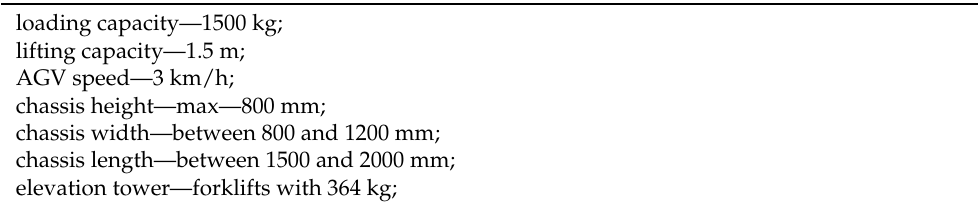
Table 3. Key technical requirements.